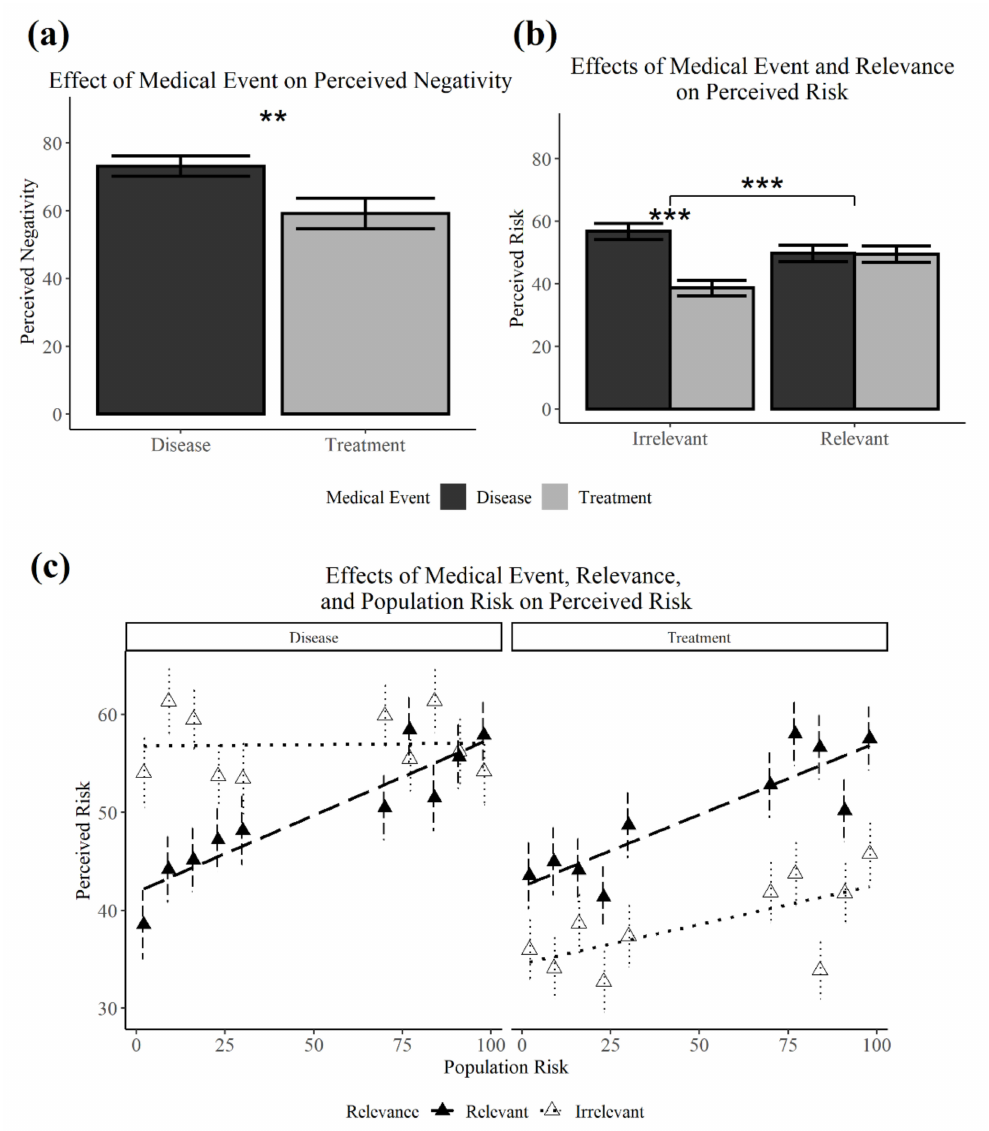
Figure A1. Effects of medical event on ( a ) perceived negativity and ( b , c ) perceived risk. The perceived negativity of disease symptoms generally exceeded that of treatment complications ( a ). The perceived risk of disease symptoms exceeded that of treatment complications when participants had knowledge of irrelevant, but not relevant population risks ( b ). The perceived risk of both disease symptoms and treatment complications increased with higher relevant population risks, while only the perceived risk of treatment complications increased with irrelevant population risks (i.e., of the disease; ( c )). Error bars represent standard error. *** p < 0.001, ** p <